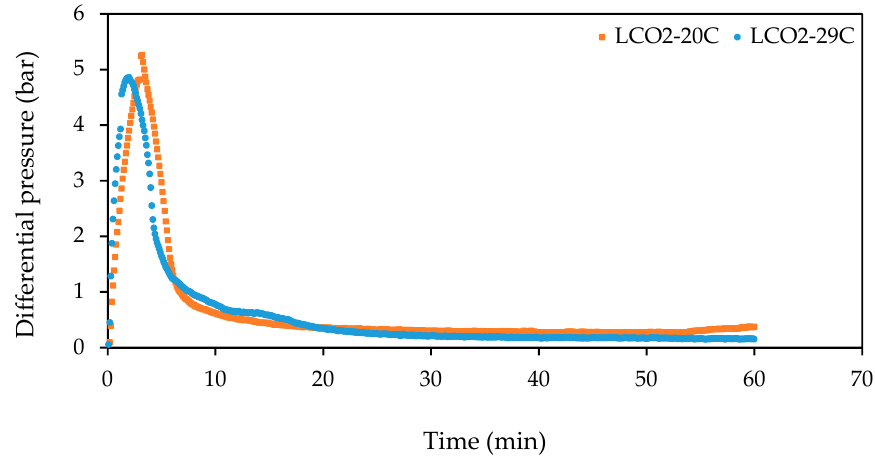
Figure 11. Effect of experimental temperature on the differential pressure profile of LCO 2 –oil displacements conducted at 0.4 mL/min and 90 bar.